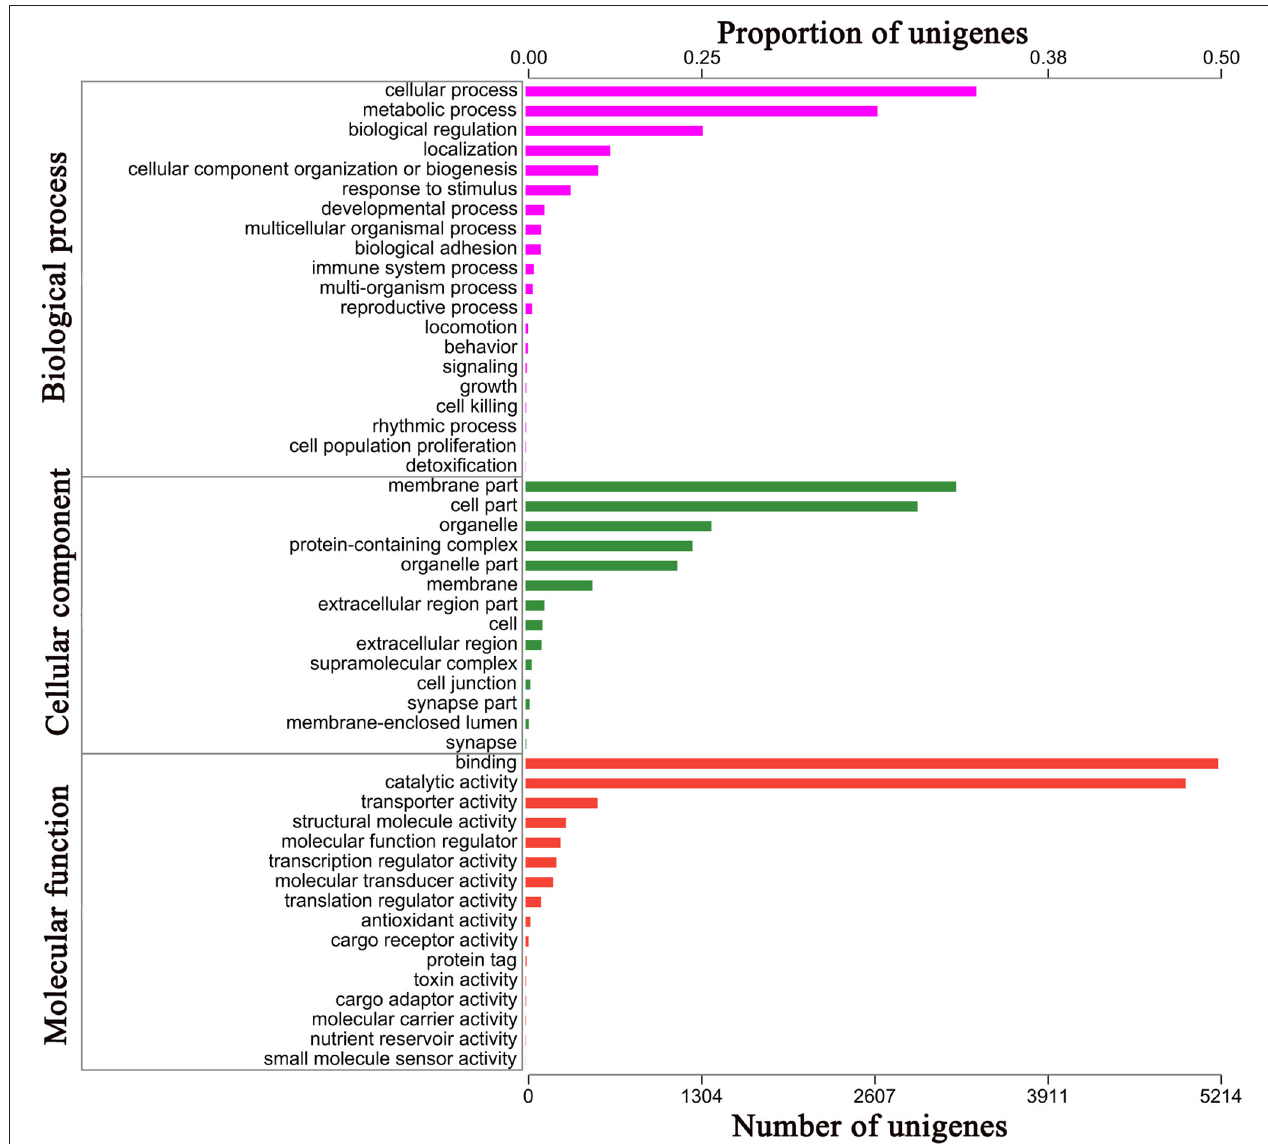
FIGURE 3 | Gene Ontology (GO) annotation results GO analysis of 10,177 genes in E. signifier transcriptome, according to their involvement in biological processes, cellular component and molecular function.